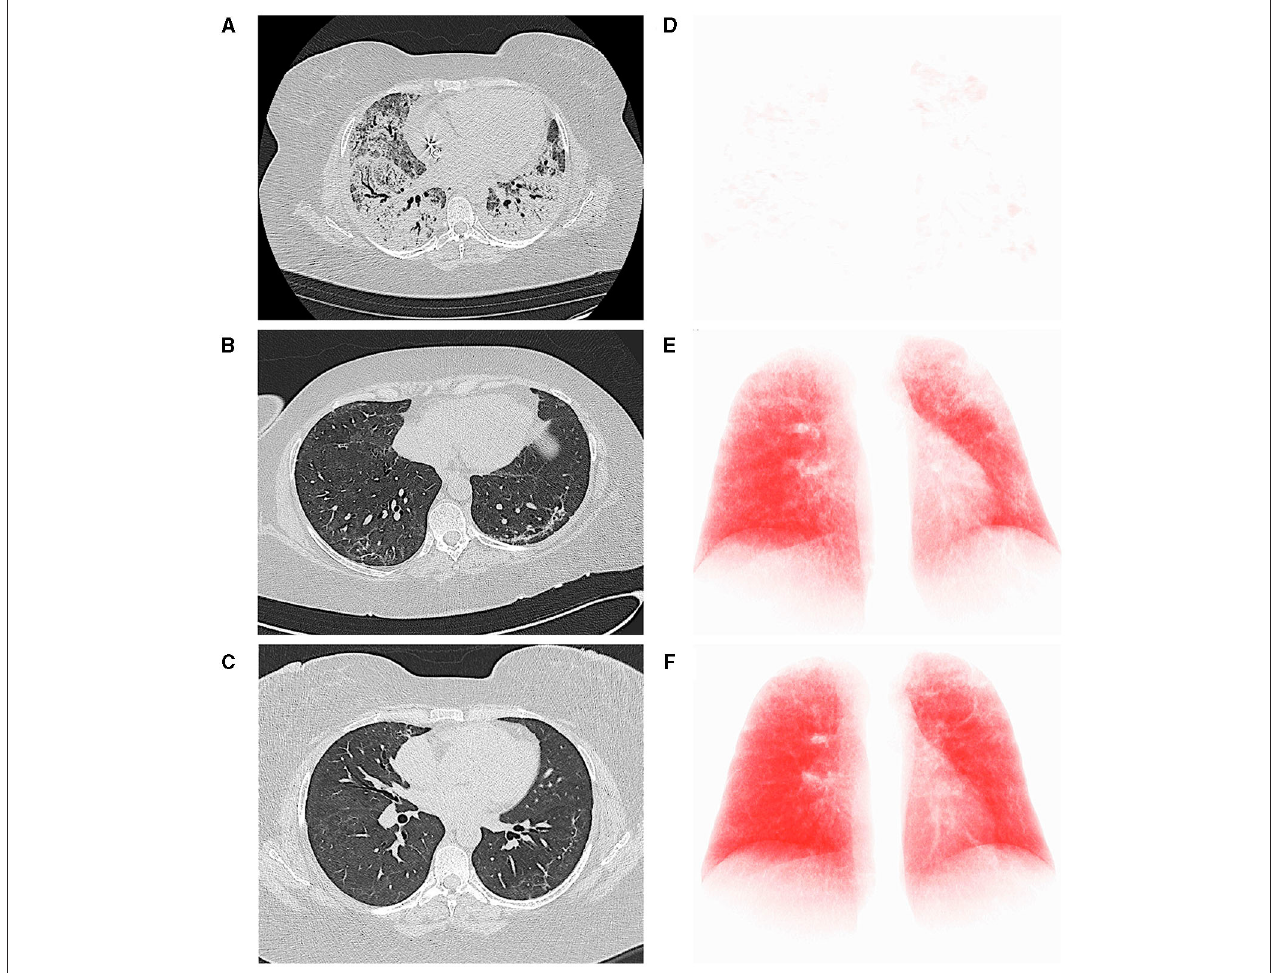
FIGURE 2 | Computed tomography (CT) axial scans (lung parenchyma windowing) acquired, respectively, immediately before (A) , 27 (B) and 111 days (C) after the start of nintedanib, demonstrating progressive improvement of lung parenchyma and significant reduction of residual lung damage. At each time point, the axial CT image most representative of the burden of lung involvement was selected. (D–F) report the corresponding three-dimensional volume rendering images (IntelliSpace Portal v.8.0, Philips Medical Systems, Eindhoven, The Netherlands). The red volume represents the well-aerated